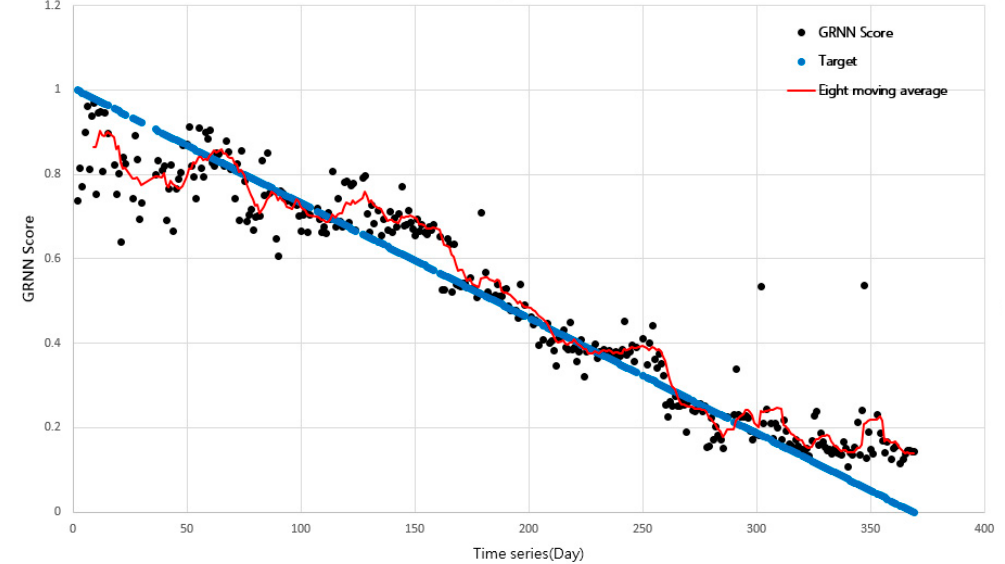
Figure 11. GRNN score (CV) for the RUL of the WHRA obtained by the GA–GRNN model.